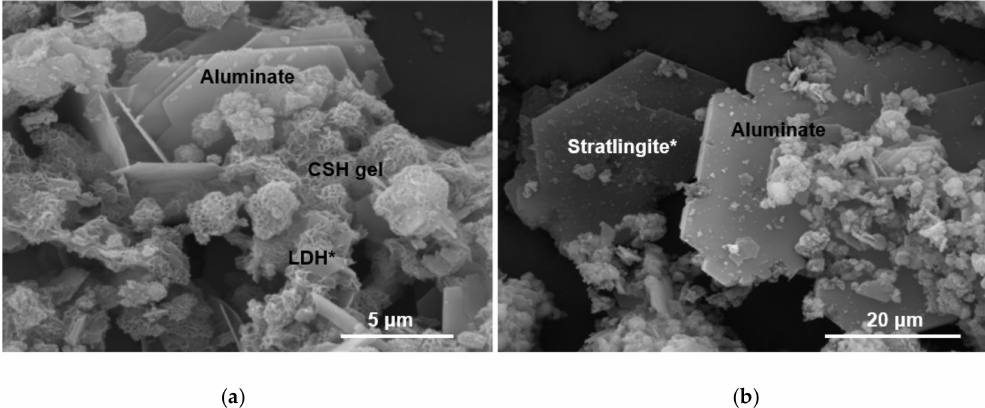
Figure 6. Solid phases present at 90 days of hydration reaction (*indicates the analysis point listed in